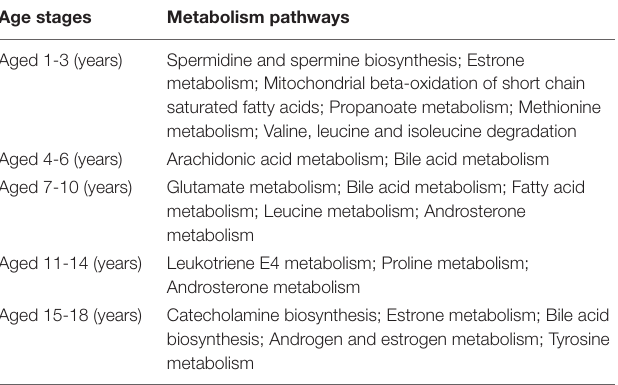
TABLE 2 | Gender dependent metabolism pathways of five age groups. Age stages